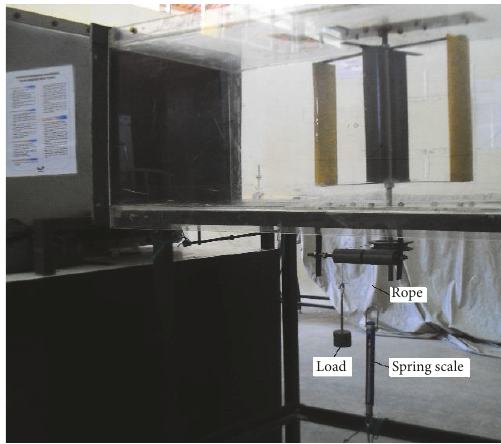
Figure 3: Photograph of turbine in wind